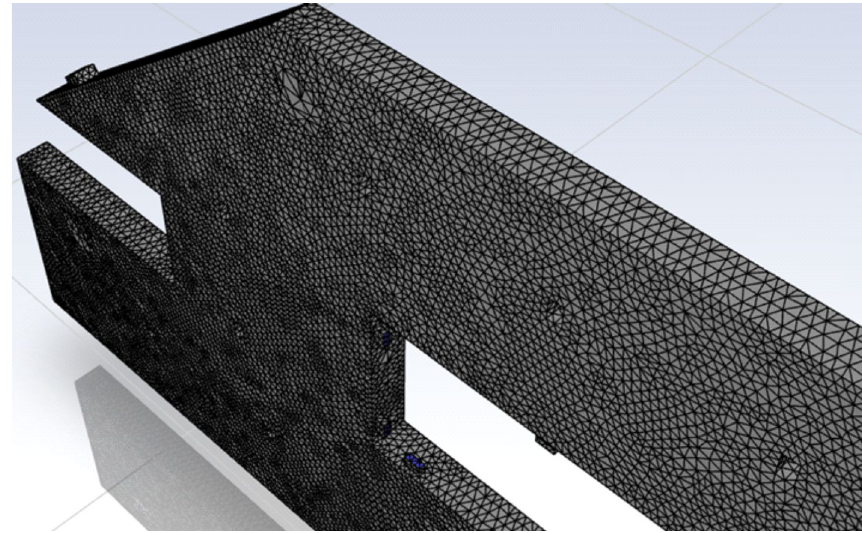
Figure 4. Numerical grid generated with the use of Ansys ICEM